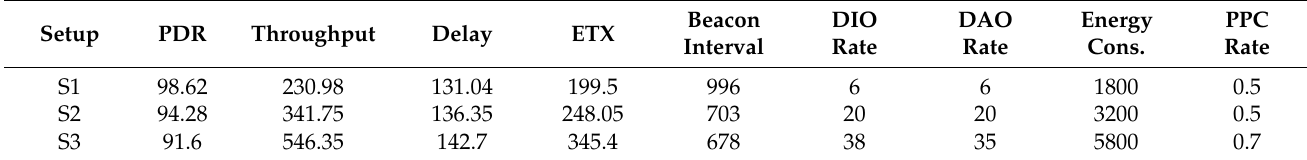
Table 3. The Results of the Standard RPL Networks Under No Attacks.